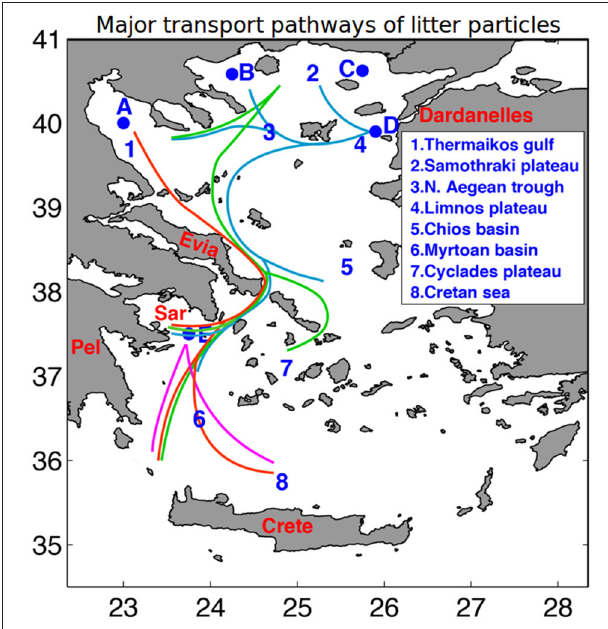
FIGURE 13 | Schematic representation of major pathways of floating litter transport among the source regions. Different colors represent pathways originated from source regions A,B,C,D, and E.